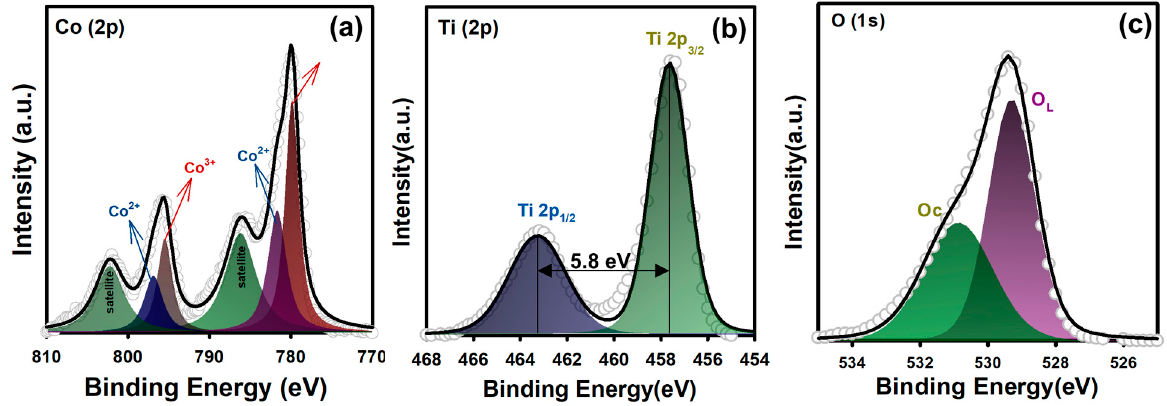
Figure 6. XPS analyses: ( a ) Co2p, ( b ) Ti2p, and ( c ) O1s of CTO.